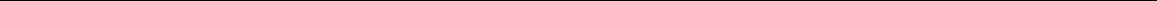
hand, no global deviation was observed in expression of the 372 assayed RBPs when comparing the various sensory cell types to mature CNS neurons or adult cortical tissues (Supplementary Fig. 13a, b and Supplementary Dataset 13).